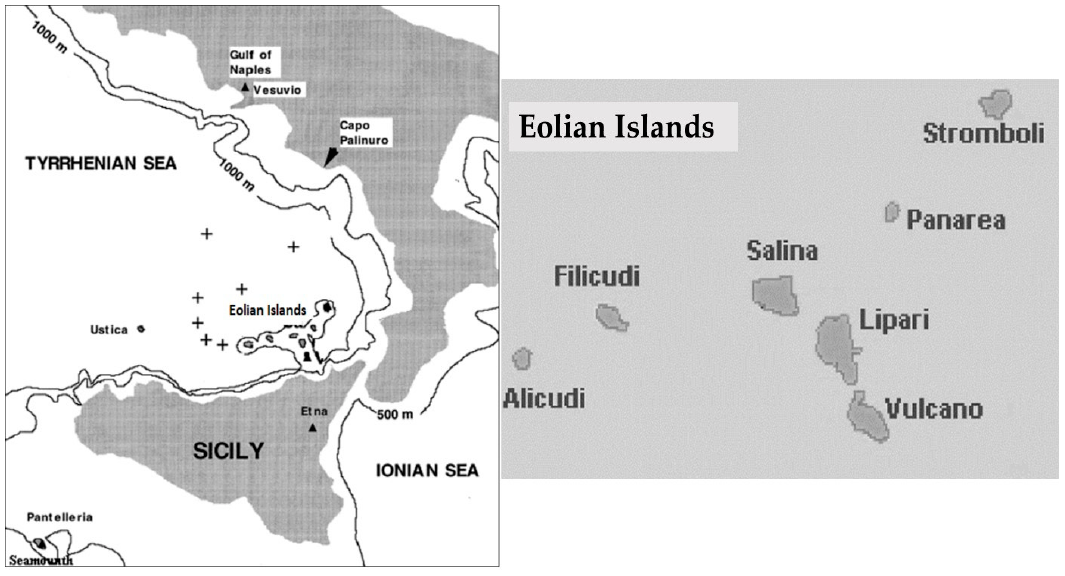
Figure 1. Hydrothermal areas in the Tyrrhenian Sea and the Eolian Islands (Italy).